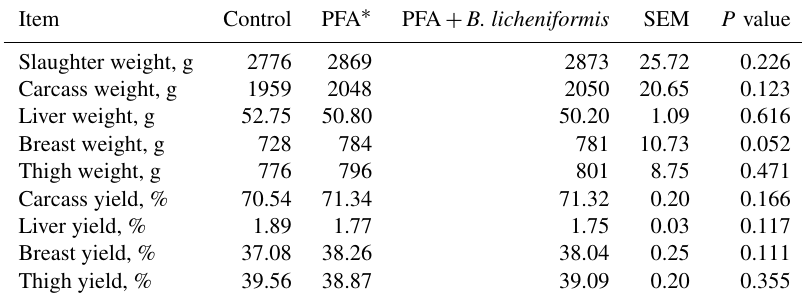
Table 3. Carcass yield and characteristics of broiler chickens fed supplemental phytogenic feed additive alone or in combination with Bacillus licheniformis